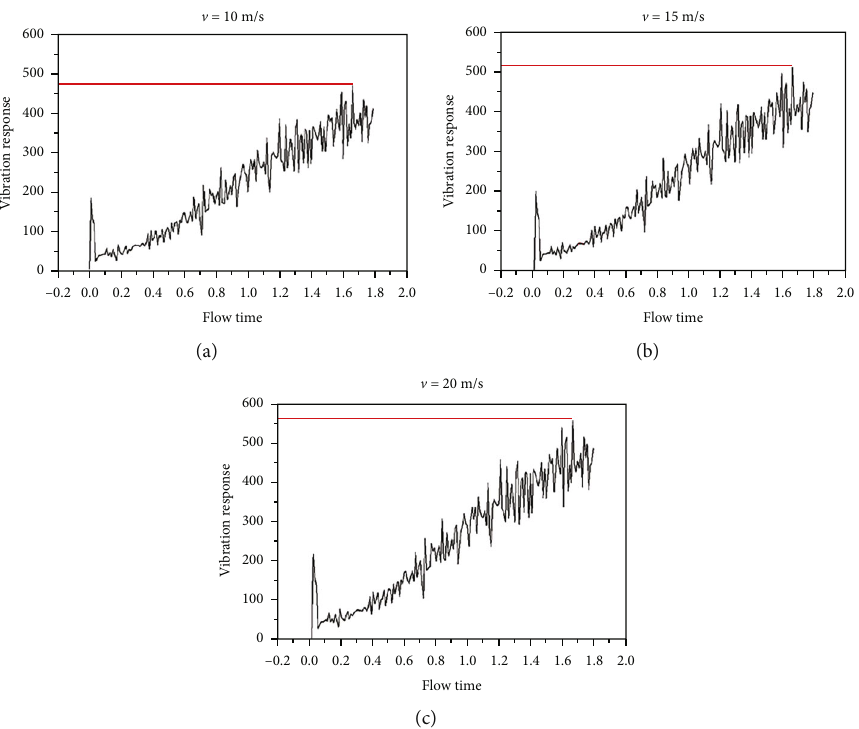
Figure 5: Wind-induced vibration responses of the saddle roof at di ff erent wind speeds, v = 10 m/s (a), v = 15 m/s (b), and v = 20 m/s (c). The red line indicates the maximum vibration response